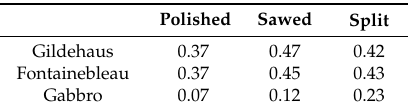
Table 3. Reflectance maxima of BDR